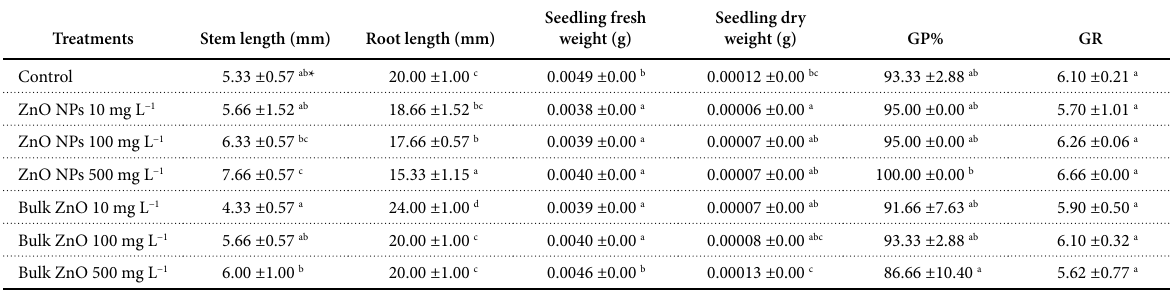
Tab. 1 Effects of ZnO NP and bulk ZnO treatments on germination properties in Portulaca oleracea L.